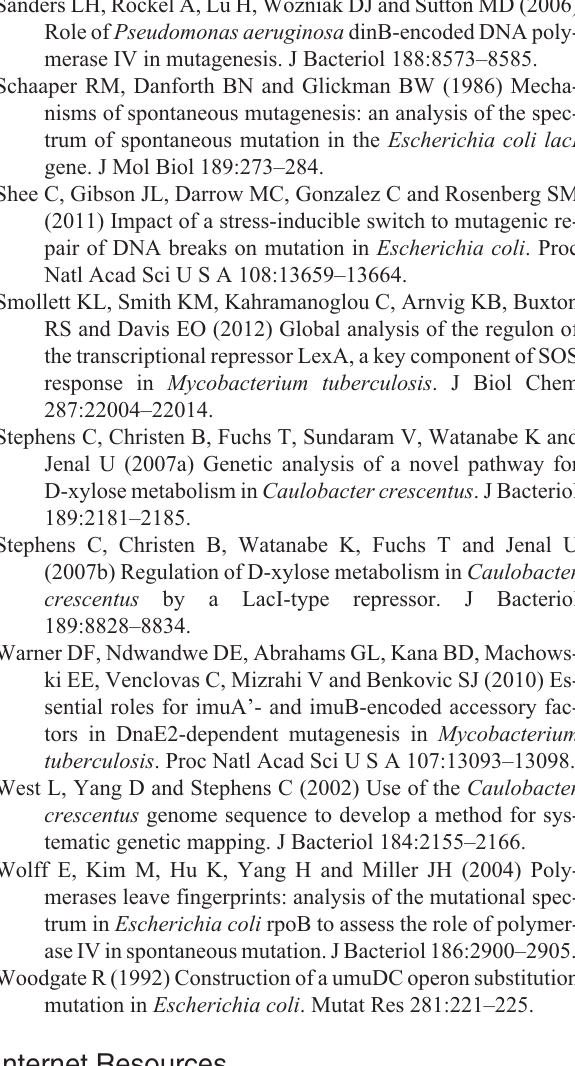
Figure S1 – Mutational hotspot in the xylR gene. Table S1 – Primers used in this study. Table S2 – Location of the mutations in the cI gene. Table S3 – Location of the mutations in the xylR